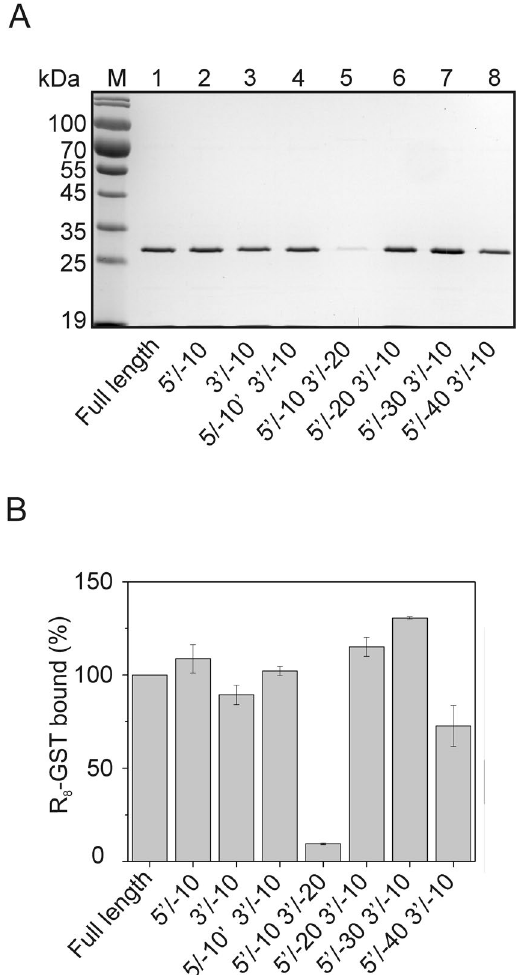
Figure 5. Identification of the 24–10 aptamer region optimal for R 8 binding. The binding of R 8 -GST to the full length 24–10 aptamer, as well as its variants appropriately shortened from the 5 ′ or 3 ′ end, was tested. ( A ) Pull down assay. Lanes: (1) full length 24–10, (2) 24–10 (5 ′ / − 10), (3) 24–10 (3 ′ / − 10), (4) 24–10 (5 ′ / − 10 and 3 ′ / − 10), (5) 24–10 (5 ′ / − 10 and 3 ′ / − 20), (6) 24–10 (5 ′ / − 20 and 3 ′ / − 10), (7) 24–10 (5 ′ / − 30 and 3 ′ / − 10) and